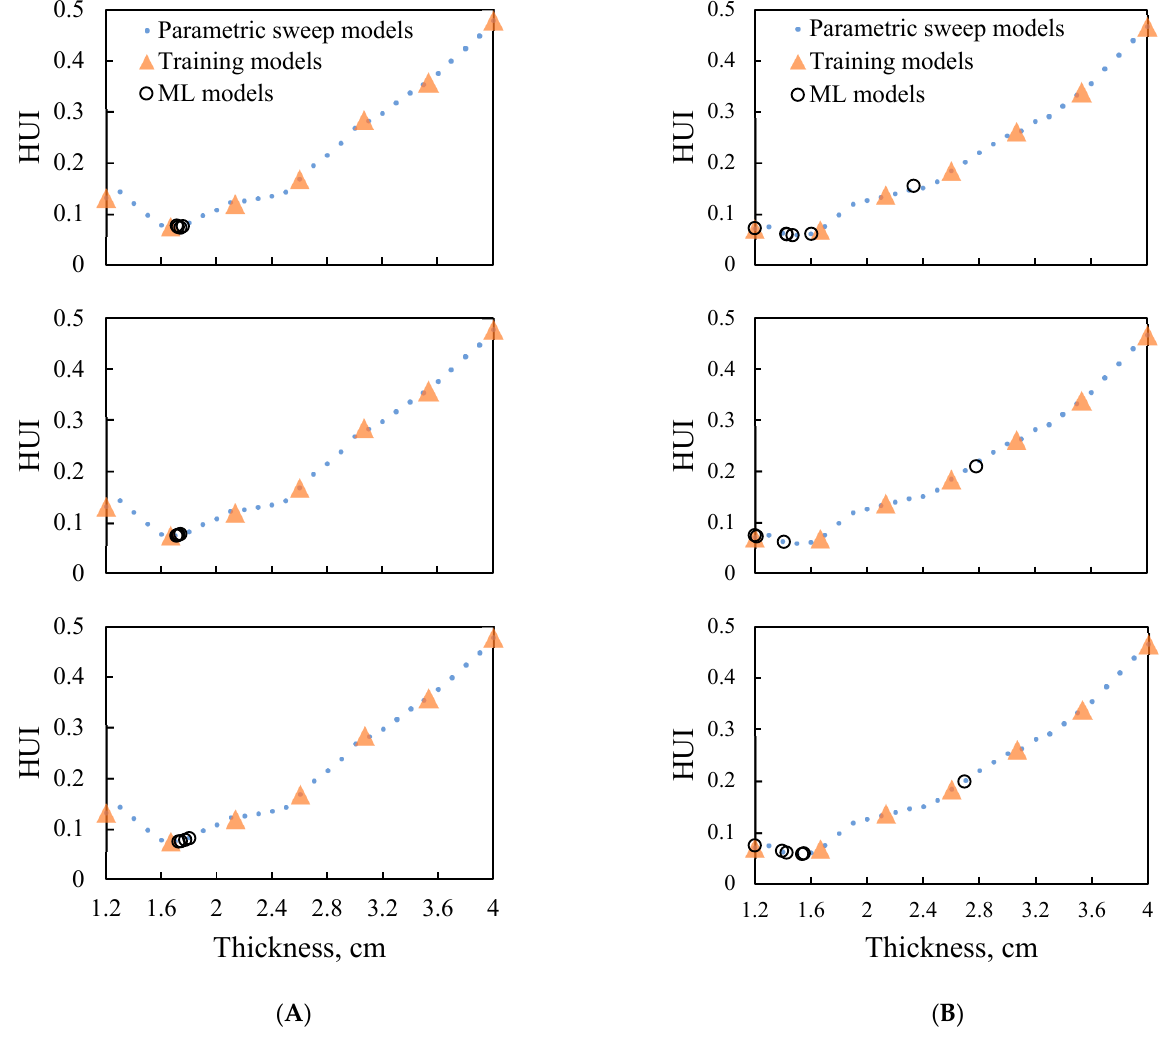
Figure 10. Machine-learning (ML) process with evenly distributed training datasets for ( A ) Conical frustum-shaped sample; ( B ) Elliptical frustum-shaped sample.